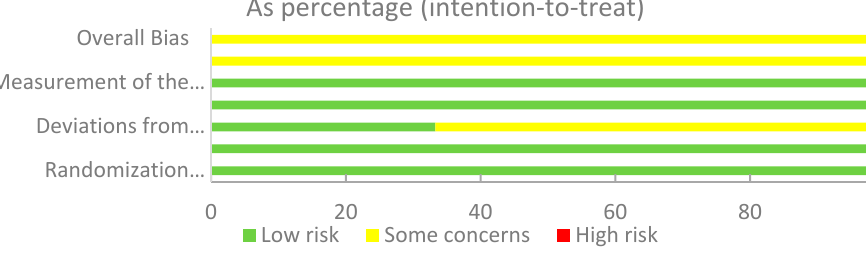
Figure 3. Risk of bias summary for the studies assessed.